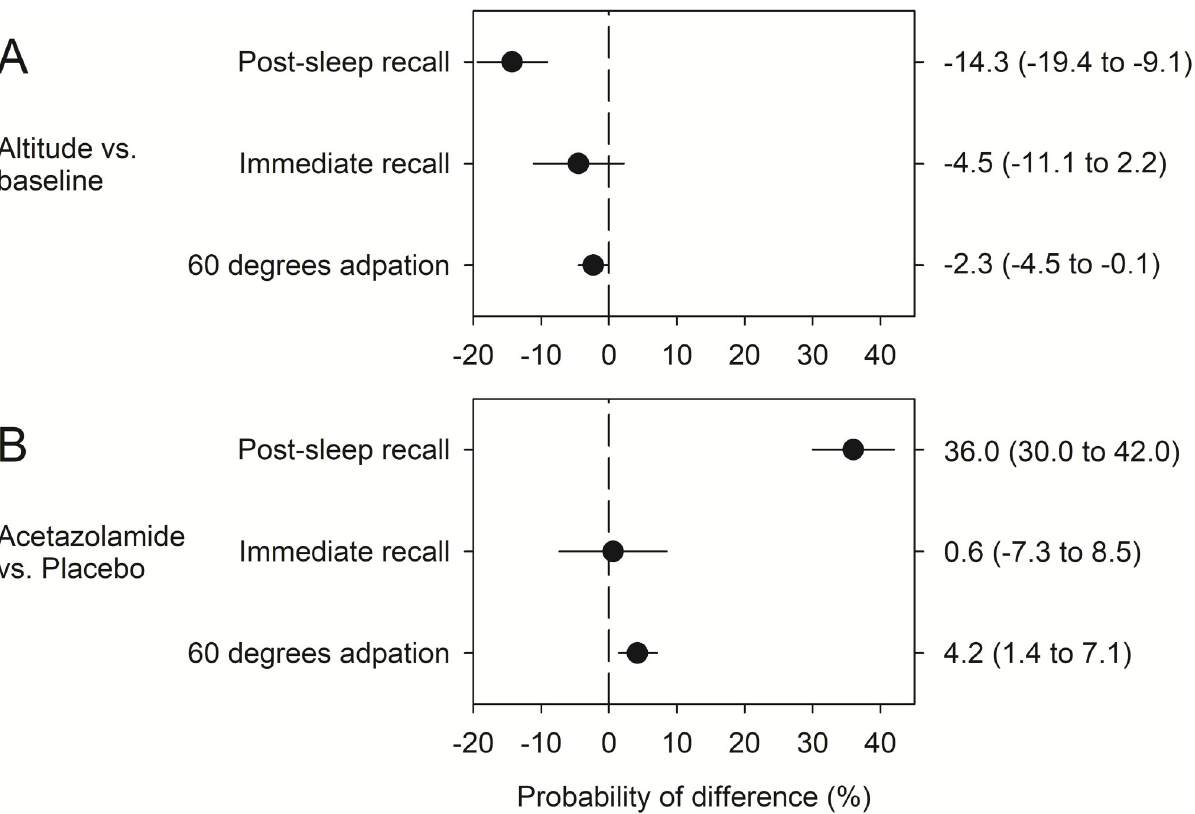
Fig 4. Effect of altitude and drug on probability of performing a valid movement. (A) Difference in the probability of performing a valid movement at altitude (3100 m) compared to baseline (760 m) during post-sleep recall, immediate recall and 60˚ adaptation under placebo. (B) Difference in altitude-induced change (3100 vs. 760 m) of the probability of performing a valid movement between acetazolamide and placebo. Results are displayed as average marginal effects with the corresponding 95% confidence intervals.